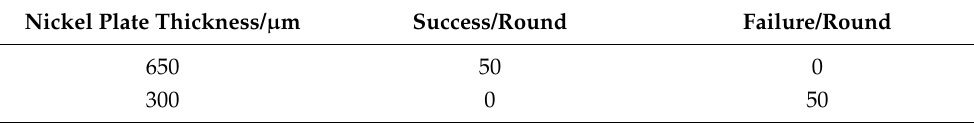
Table 8. Arming safety test